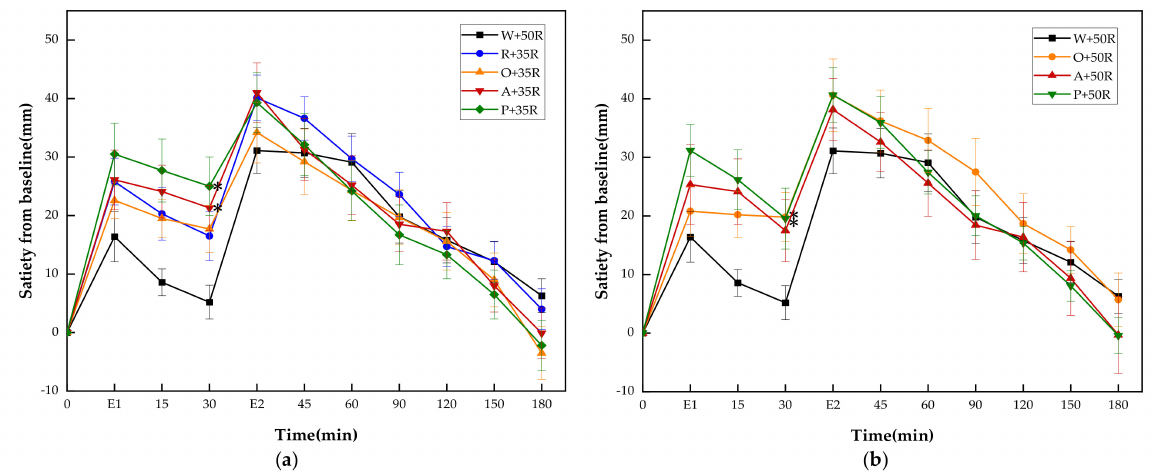
Figure 5. ( a ) Satiety responses for reference and IC test meals; ( b ) satiety responses for reference and HC test meals. E1, the end point of preload consumption; E2, the end point of rice consumption. G, glucose; R, rice; O, oranges; A, apples; P, pears; W, water. Data are given as mean ± SE, n = 14. * Test meals different from W +